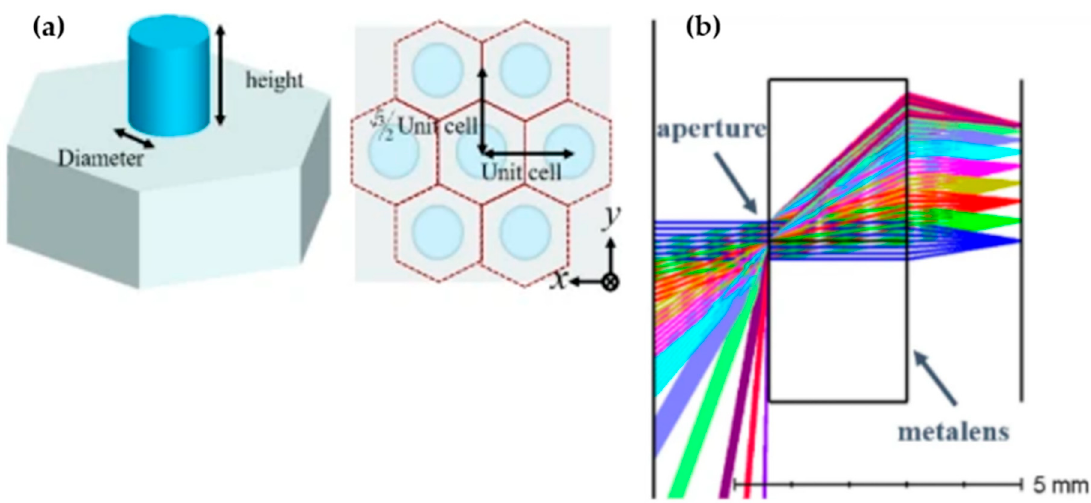
Figure 20. ( a ) The geometry of a unit cell. ( b ) The metalens layout. Reprinted from [71]. CC by 4.0.